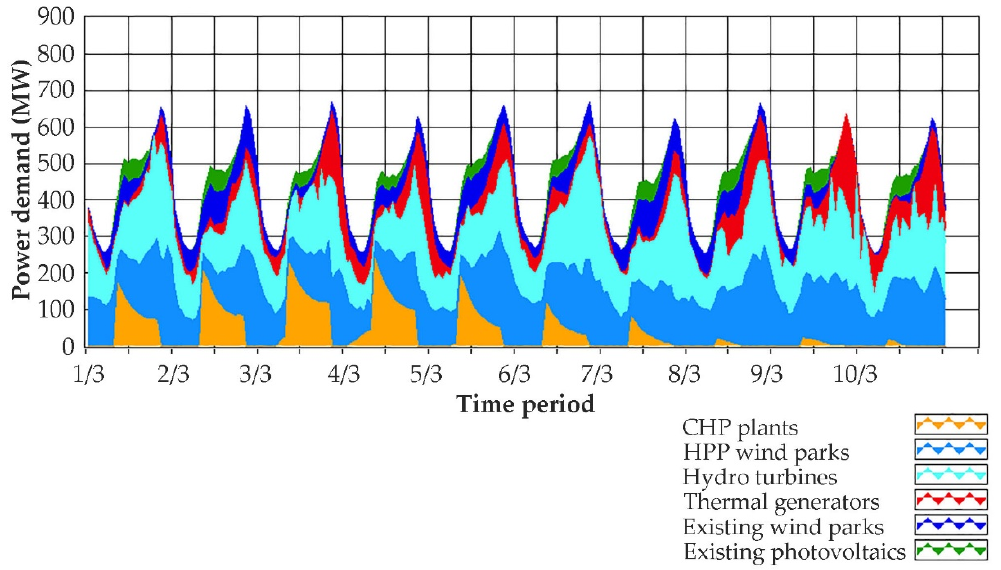
Figure 28. Synthesis of the power production in Crete with all the investigated technologies from the 1st to the 10th of March.